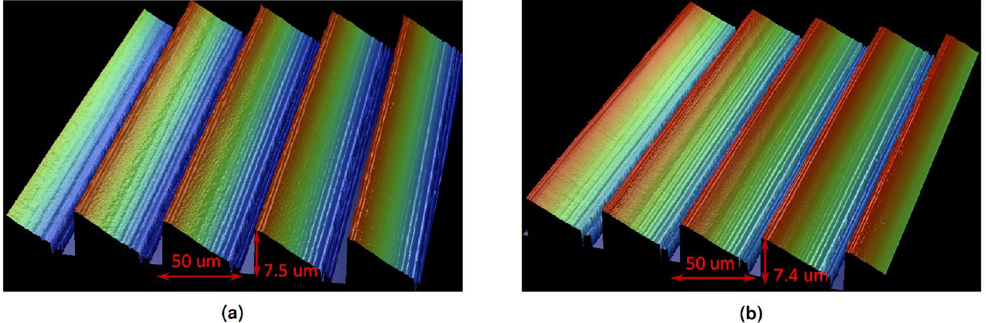
Figure 1. 3D profiles of optical micro grating structures measured by using Wyko NT3300 profilometer: ( a ) Master grating on Epocore by laser ablation; ( b ) Replicated grating structure on NOA 74 UV cured resin layers by soft